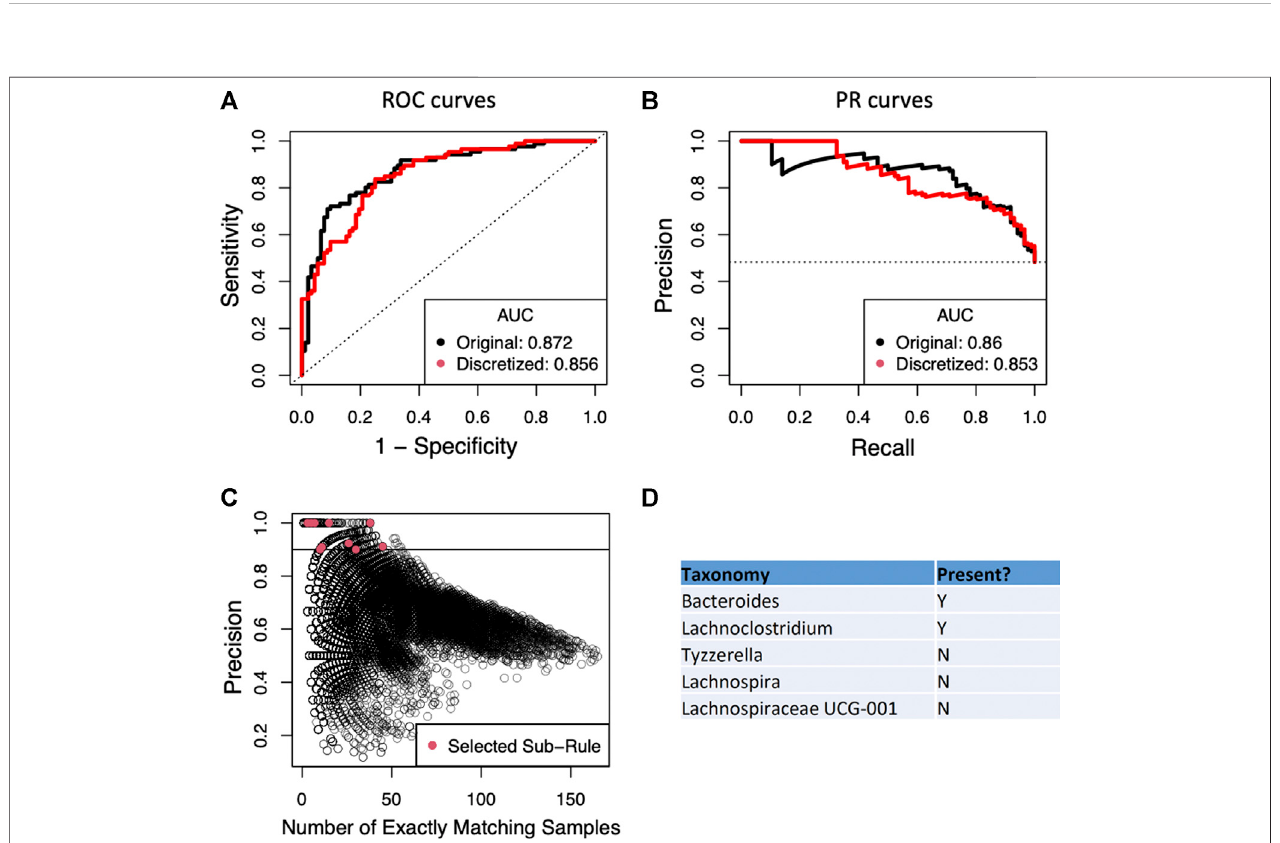
FIGURE 3 | (A) Performance of the random forest classi fi er as measured by area under the receiver operator curve (ROC-AUC) is not strongly perturbed by simplifying OTU representation toapresence/absence scheme vs. the originalcontinuouscount. Dashed lineindicates theperformance ofaperfectly random classi fi er. (B) The area under the curve of the precision recall curve is similarly not strongly affected by the new representation scheme. Dashed horizontal line is the random performanceline. (C) Each pointrepresentsauniquecandidatesub-rule.Onthe x -axisisthenumberofsamplesinthedatamatrixthataresubjecttothatrule. The y -axisrepresentswhatfractionofmatchingsampleswerediagnosedasCrohn ’ sdisease. (D) ThetaxonidentitiesoftheOTUsthatmakeupthemostgenerallyapplicable of the sub-rules where all matching samples have the Crohn ’ s disease label.